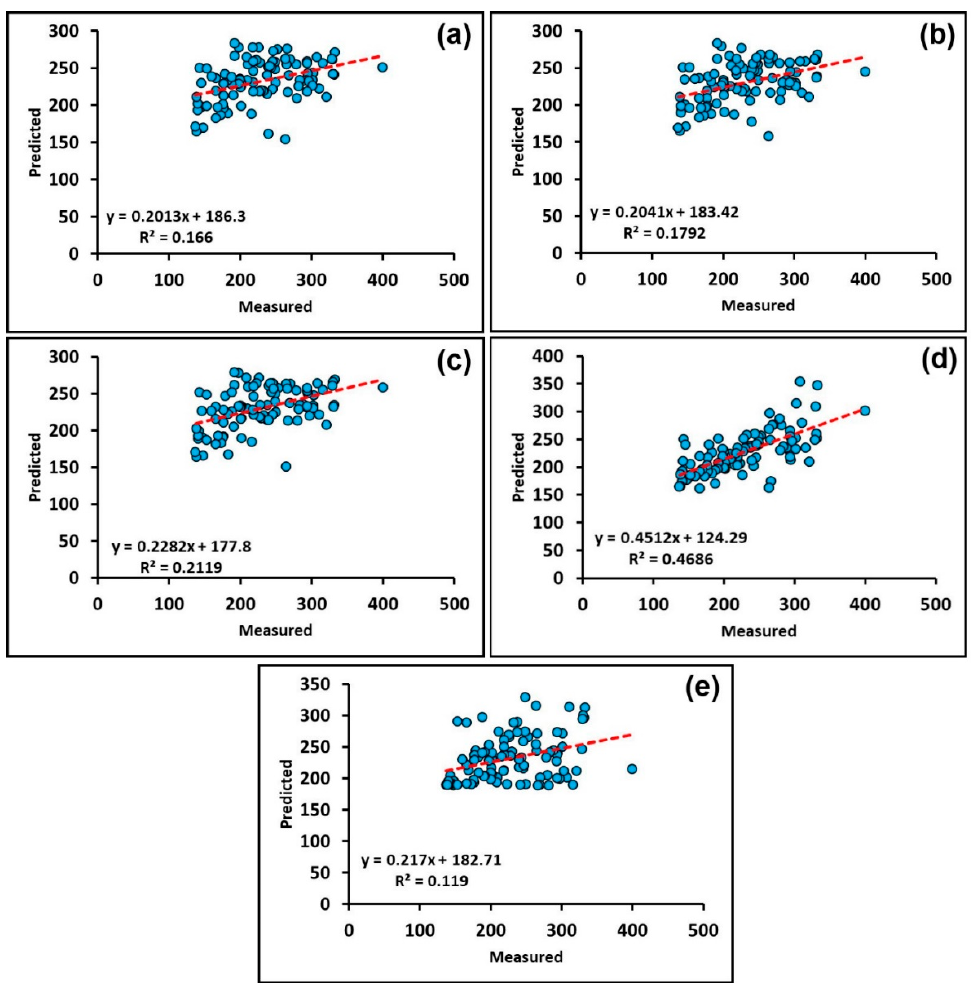
Figure 8. Scatter plot of measured and predicted amounts of annual precipitation of the compared five interpolation methods. ( a ) IDW, ( b ) RBF: Spline with Tension, ( c ) Kriging: Simple Kriging, ( d ) Co-Kriging: Ordinary Co-Kriging, ( e ) Non-linear regression: Sinusoidal equation.